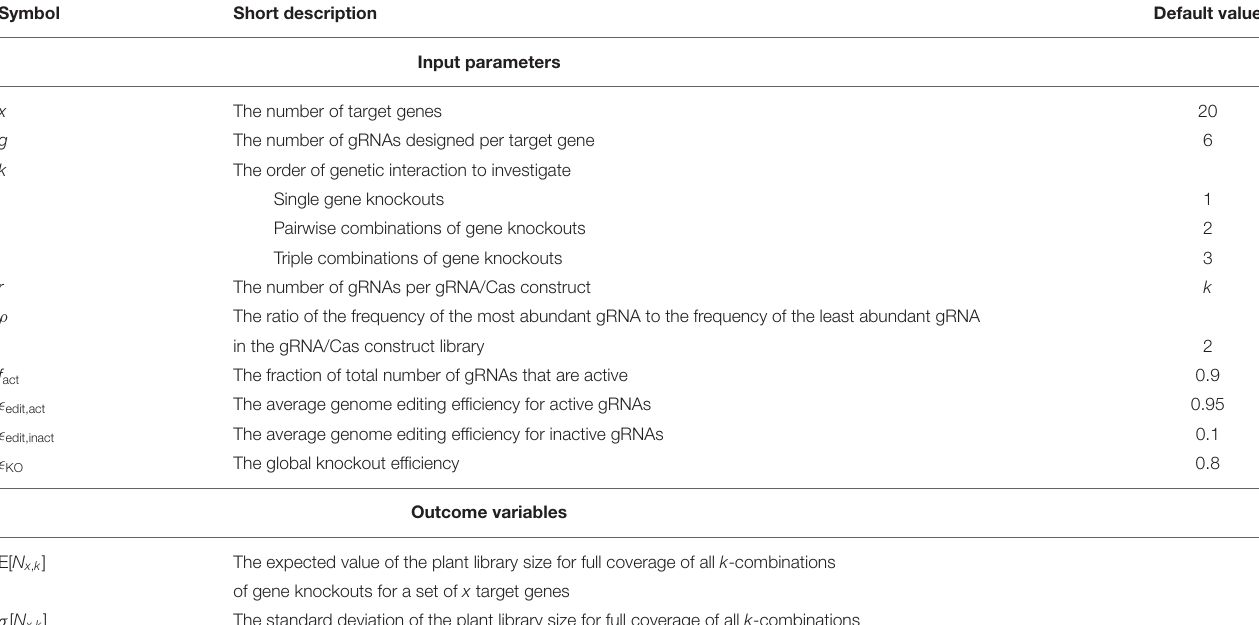
TABLE 2 | Input parameters and outcome variables of the multiplex CRISPR/Cas simulation experiment.